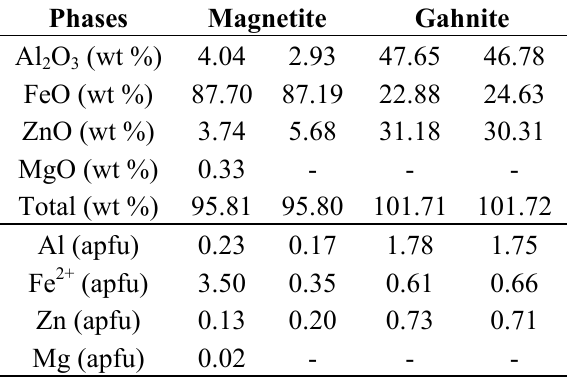
Table 3. Chemical compositions of spinel group phases obtained by EDS. “-” indicates non-detected. Structural formulae (apfu: atoms per formula unit) were calculated on the basis of four